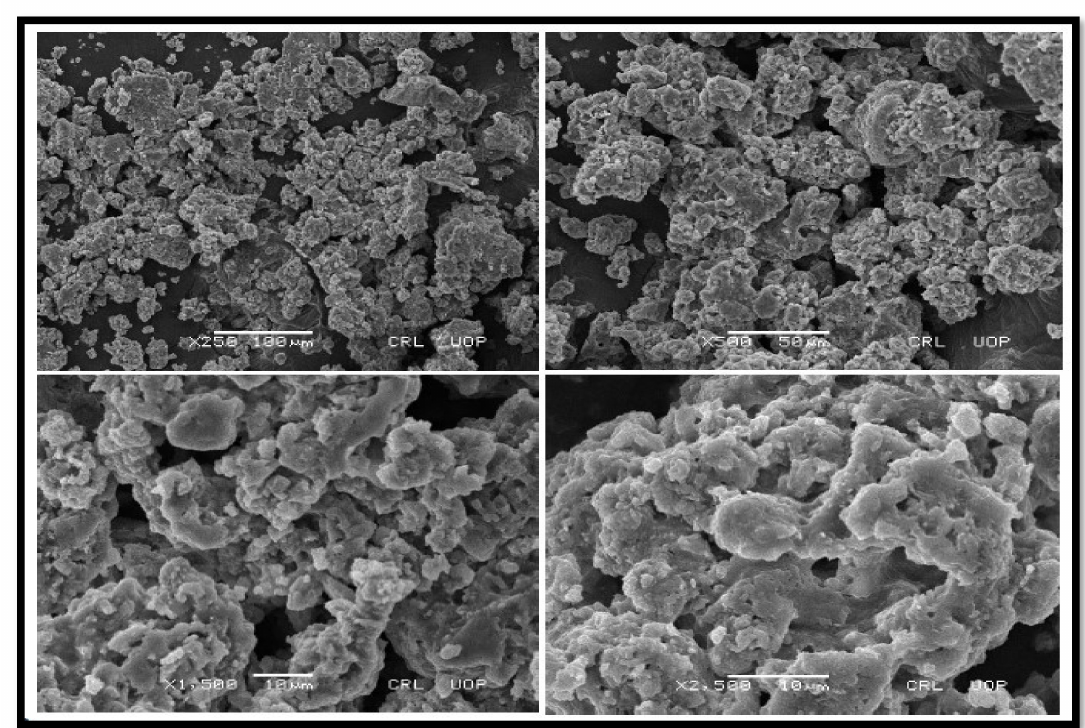
Figure 7. SEM images of KPC with dissimilar magnifications.